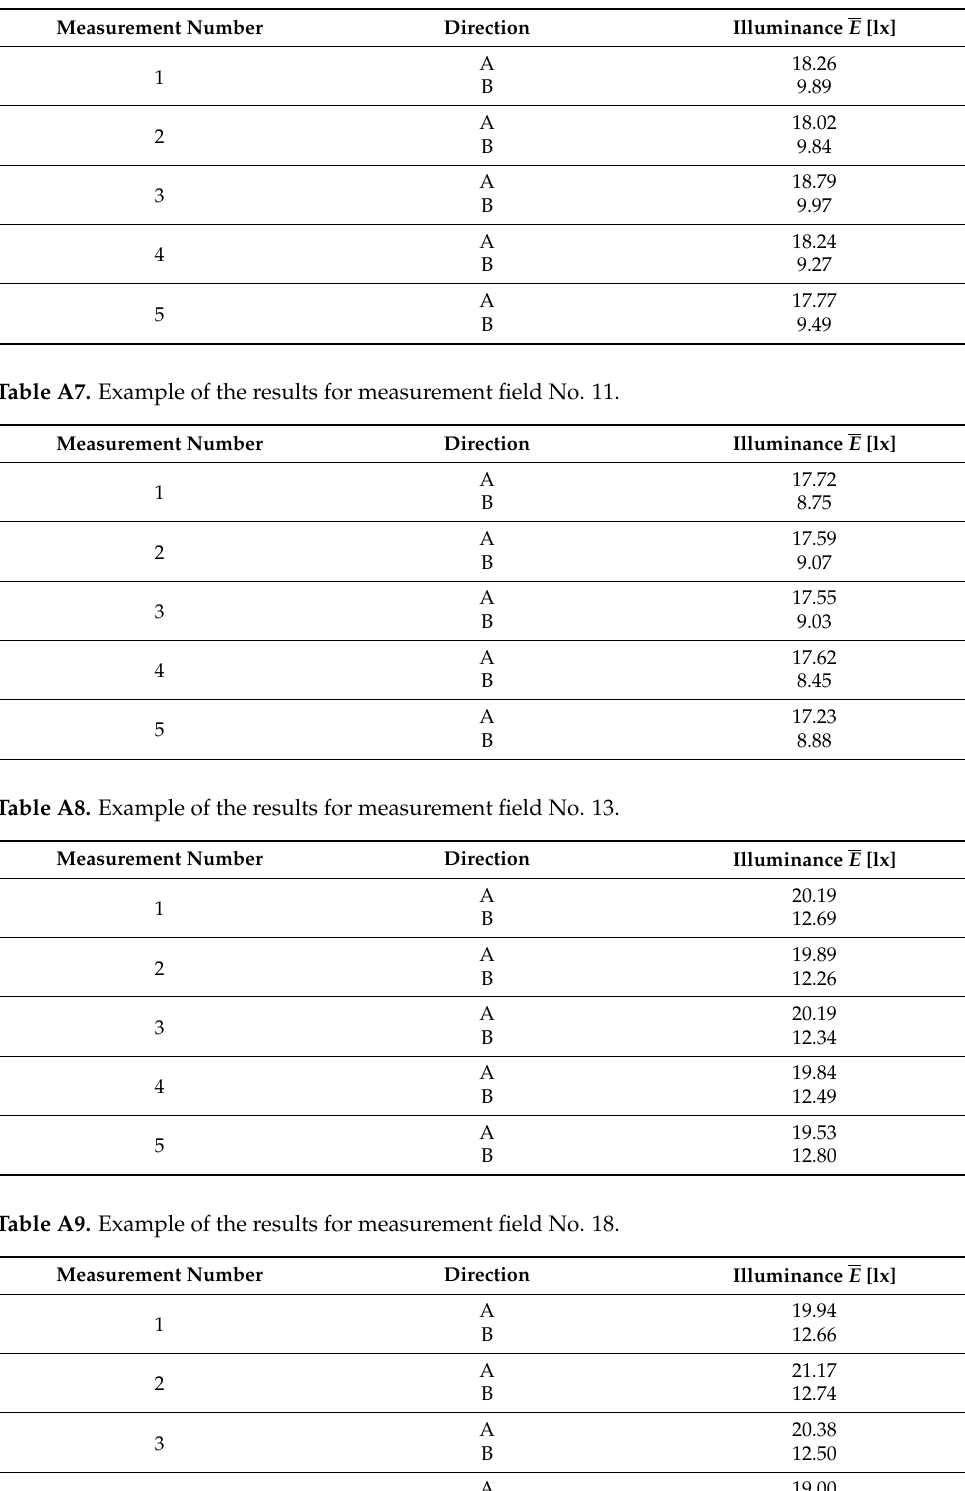
Table A6. Example of the results for measurement field No. 10.